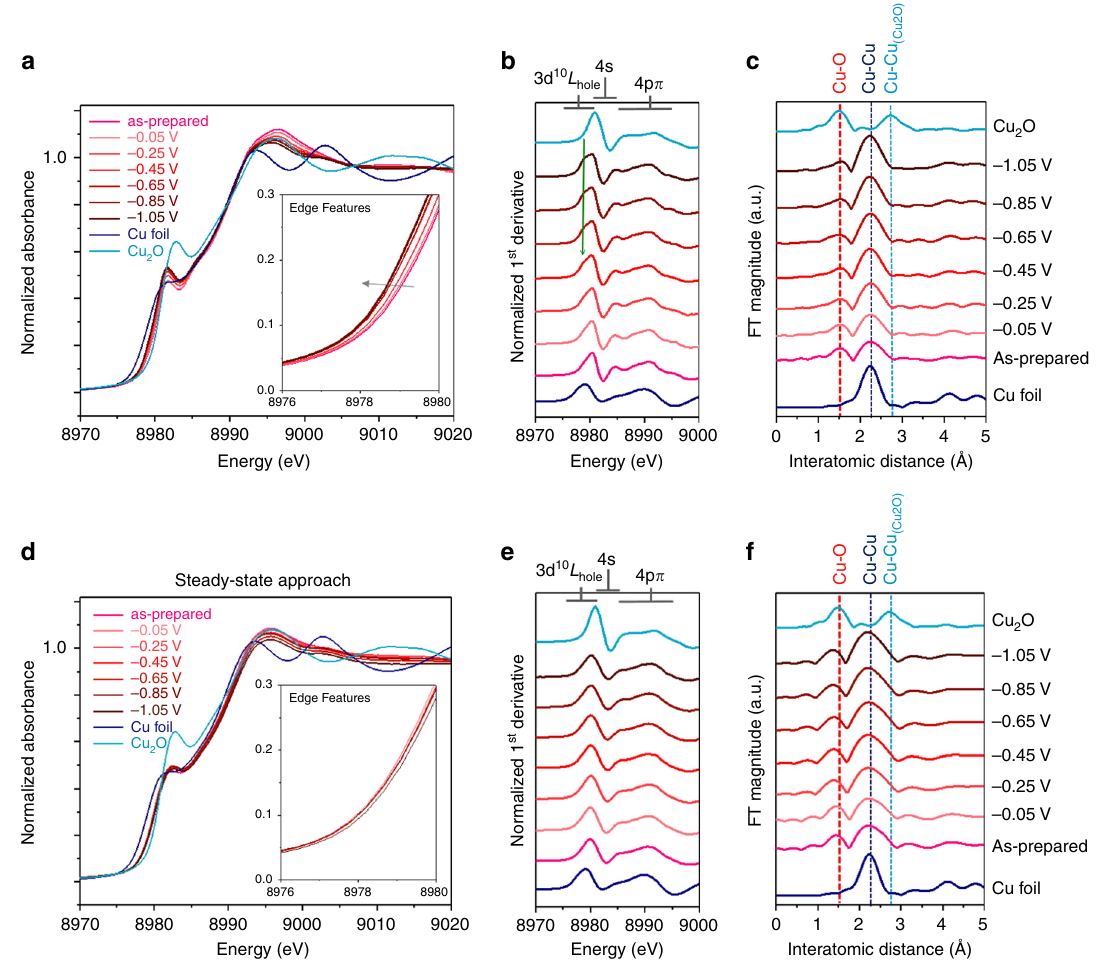
Fig. 3 Conventional operando XAS characterization. a Potential dependence of operando Cu K edge XANES spectra without phase-correction of the CuO x under CO 2 RR in 0.5 M CO 2 -saturated KHCO 3 using chronoamperometry (CA) and the corresponding 1st derivative spectra ( b ). c Potential dependence of operando EXAFS spectra of the CuO x under eCO 2 RR in 0.5 M CO 2 -saturated KHCO 3 using CA. d Potential dependence of operando Cu K edge XANES spectra without phase-correction of the CuO x under CO 2 RR in 0.5 M CO 2 -saturated KHCO 3 using R.S. and the corresponding 1st derivative spectra ( e ). f Potential dependence of operando EXAFS spectra of the CuO x under eCO 2 RR in 0.5 M CO 2 -saturated KHCO 3 using